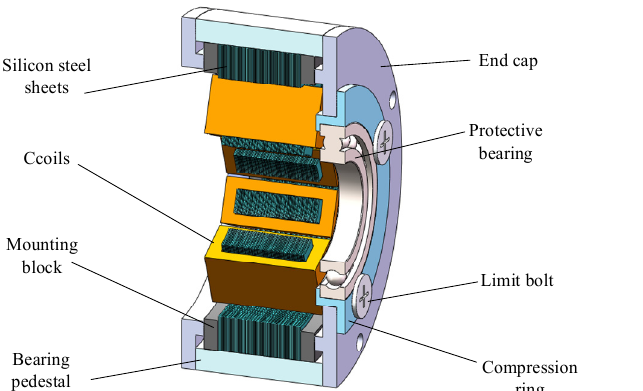
Figure 11. The 8-pole RMB 3D Figure 11. The 8 ‐ pole RMB 3D model.